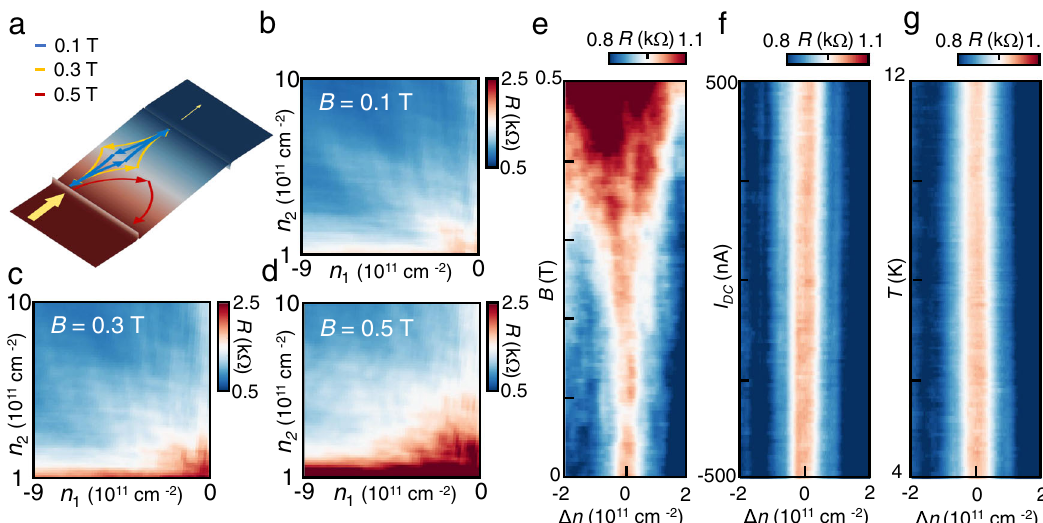
Fig.3|Dependenceonmagnetic fi eld,biasandtemperature.a Simulatedtypical carrier trajectories under various small magnetic fi elds. b , c Veselago interference peaks gradually broadens with increasing magnetic fi eld and d is eventually sup- pressedwhenmajorityofthecarriersfailtoformtheinterferenceloop. e Measured